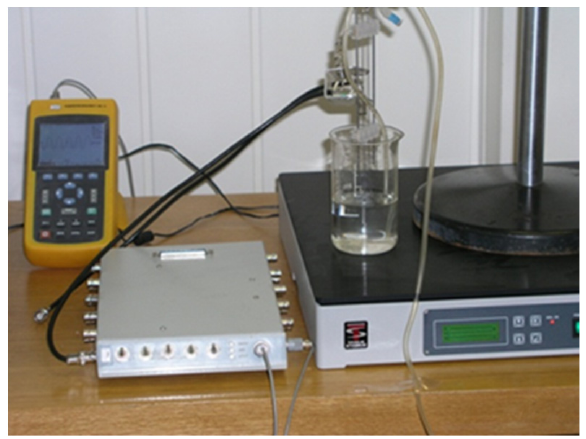
Figure 2. Calibration stand and equipment.